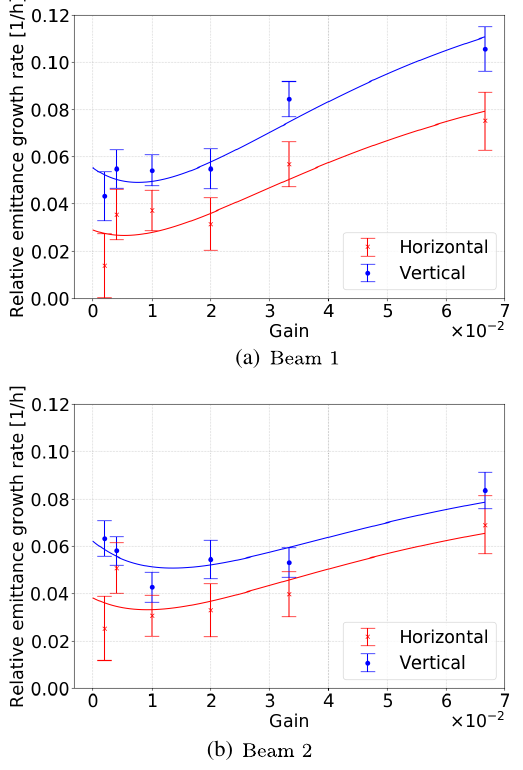
FIG. 9. Measured relative emittance growth rate as a function of the feedback gain for single bunches colliding at 6.5 TeV in IPs 1 and 5 featuring a total beam-beam tune shift of 0.02 during a dedicated experiment at the LHC in 2017. Other contributions to the emittance growth rate such as intrabeam scattering [29] are remove based on the measurement of the emittance growth rate of a noncolliding bunch with similar properties. The data is fitted with Eq. (1), the corresponding parameters are shown in Table II. The details of the experiment may be found in [30].